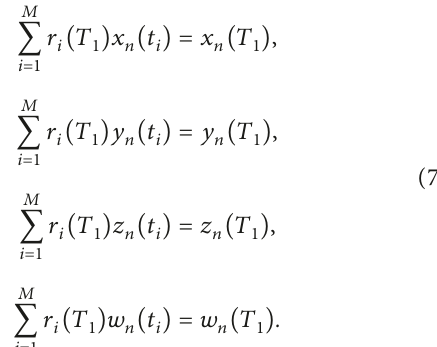
Figure 10: Phase portraits of Experiment 1 with a � 4 , b � 5 ,t � 1000: ( a ) on y − z − w plane; ( d 3